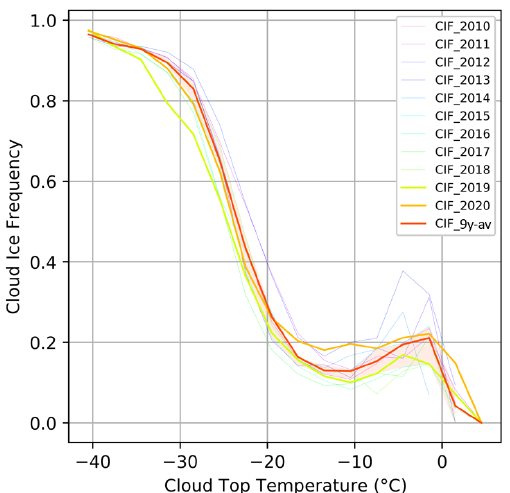
Figure 12. Temperature-dependent CIFs at the latitude band be- tween 75 and 85 ◦ N for the years 2010 to 2020, and the average for 2010–2018 (with the shaded area covering the 25th to 75th per-